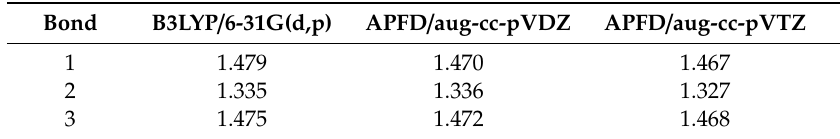
Table 9. Computed structures for N -methylpyrrole N -oxide corresponding to the designated bonds shown in the figure in Table 8. There are no experimental data for this presently unknown molecule. Computed bond lengths (Angstroms) for N -methylpyrrole N